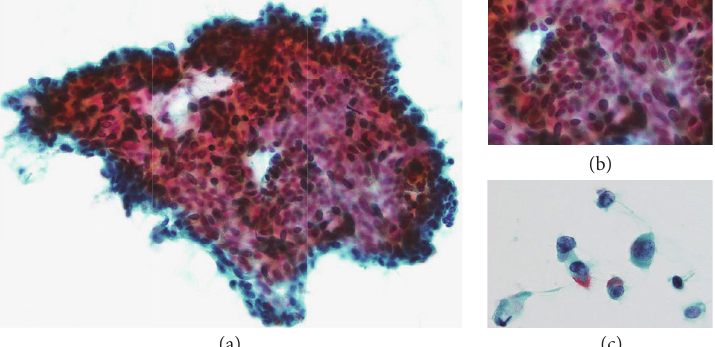
Figure 2: (a) Tumor cells form a papillary and conglomerate mass. Individual tumor cells have a round to short spindle-shaped nucleus with granular chromatin (Papanicolaou stain, original magnification × 400). (b) Individual tumor cells have a round to short spindle-shaped nucleus with granular chromatin. Nuclear atypia is not prominent. Some tumor cells show ill-defined rosette formation (Papanicolaou stain, original magnification × 1000). (c) Some tumor cells remain as separate cells rather than forming a mass. Many of these tumor cells contain cytoplasmic mucin. There are no prominent nucleoli (Papanicolaou stain, original magnification ×